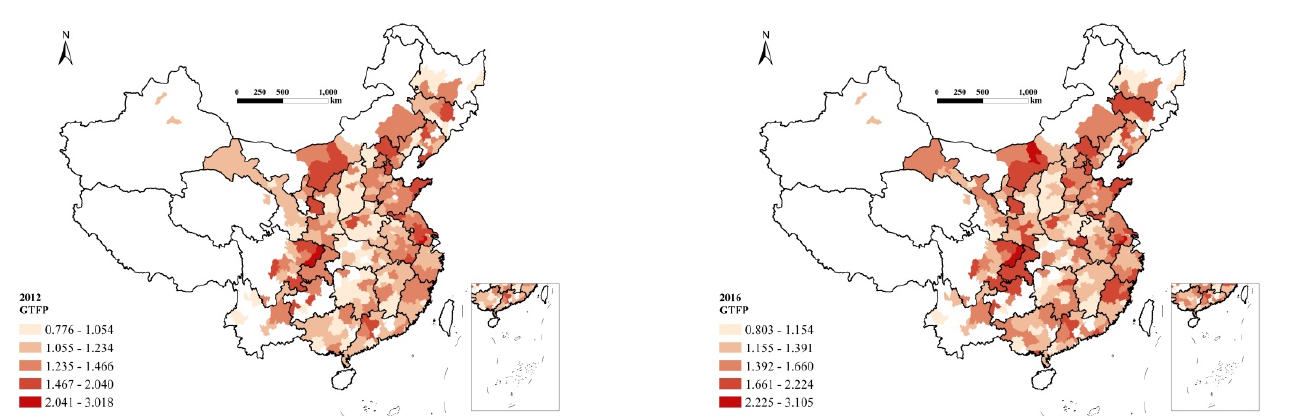
Figure 1. Spatial distribution of GTFP scores of 259 cities in 2005, 2009, 2012, and 2016. In general, the spatial distribution of GTFP scores of Chinese cities changed over time. In 2005, the cities with higher GTFP scores were found mainly in the Hohhot-Baotou-Ordos urban agglomeration in Inner Mongolia, the Yangtze River Delta urban agglomeration, and the Sichuan-Chongqing urban agglomeration. In contrast, the cities in the southwestern regions have the lowest scores. Cities in the northeastern and central regions have medium scores. Compared with 2005, the spatiotemporal variations of GTFPs in 2009 changed slightly. However, we noticed GTFP improvements in the Shandong Peninsula and decreases in the Sichuan-Chongqing urban agglomeration.